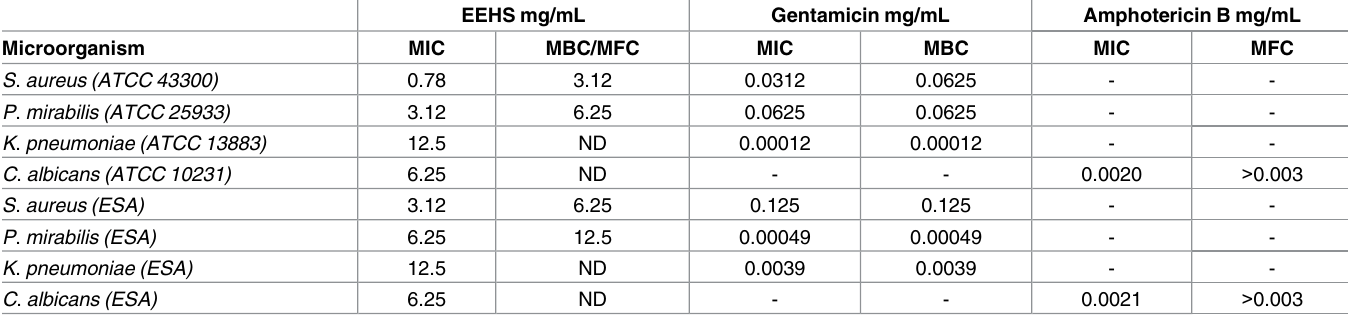
Table 3. Minimal inhibitory concentration (MIC), minimum bactericidal concentration (MBC), and minimum fungicidal concentration (MFC) of the EEHS and